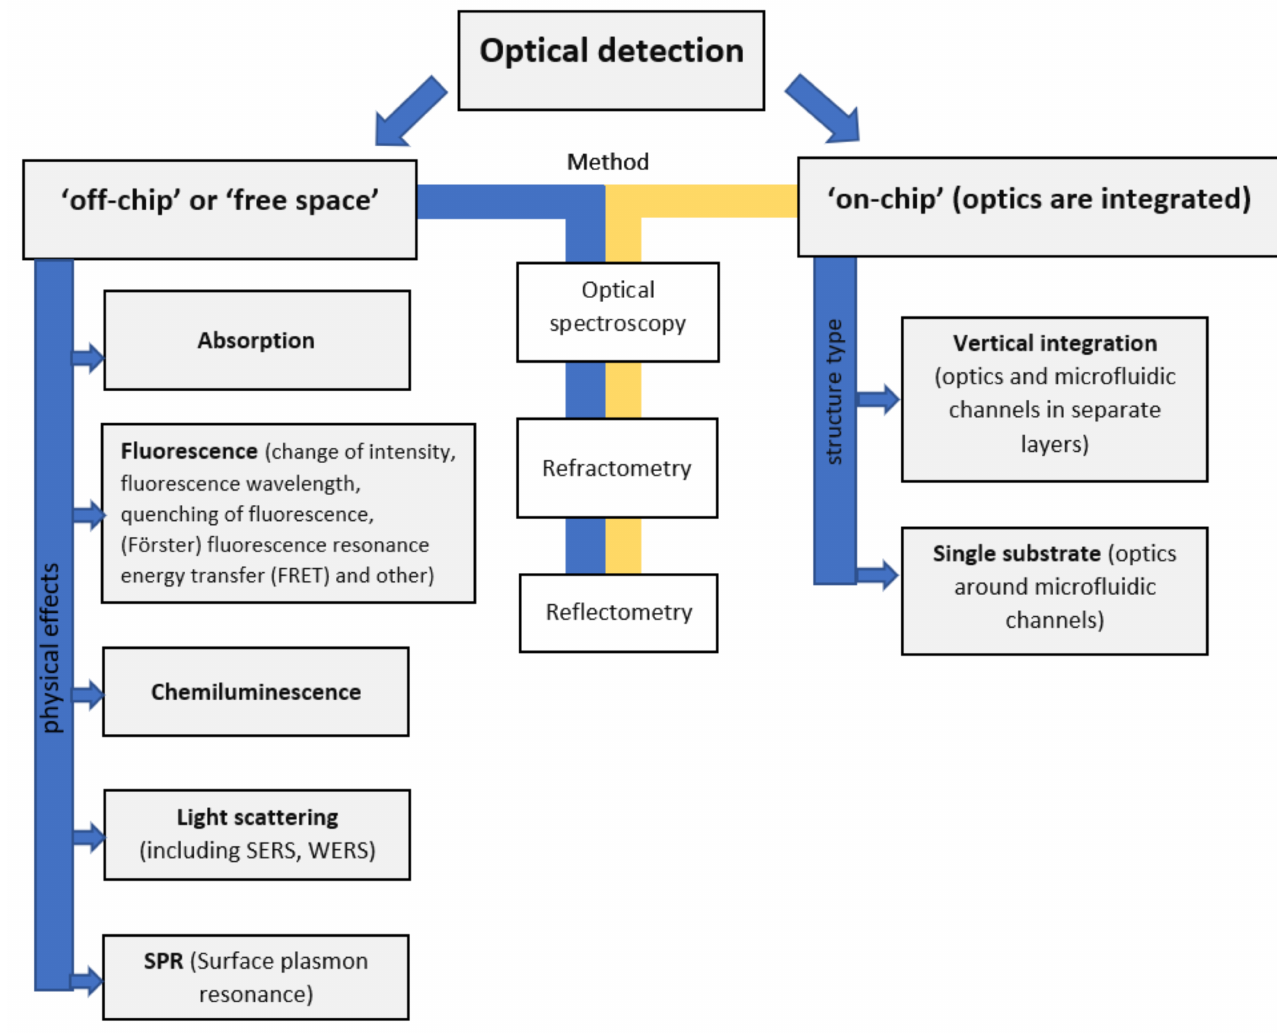
Figure 10. Optical detection in